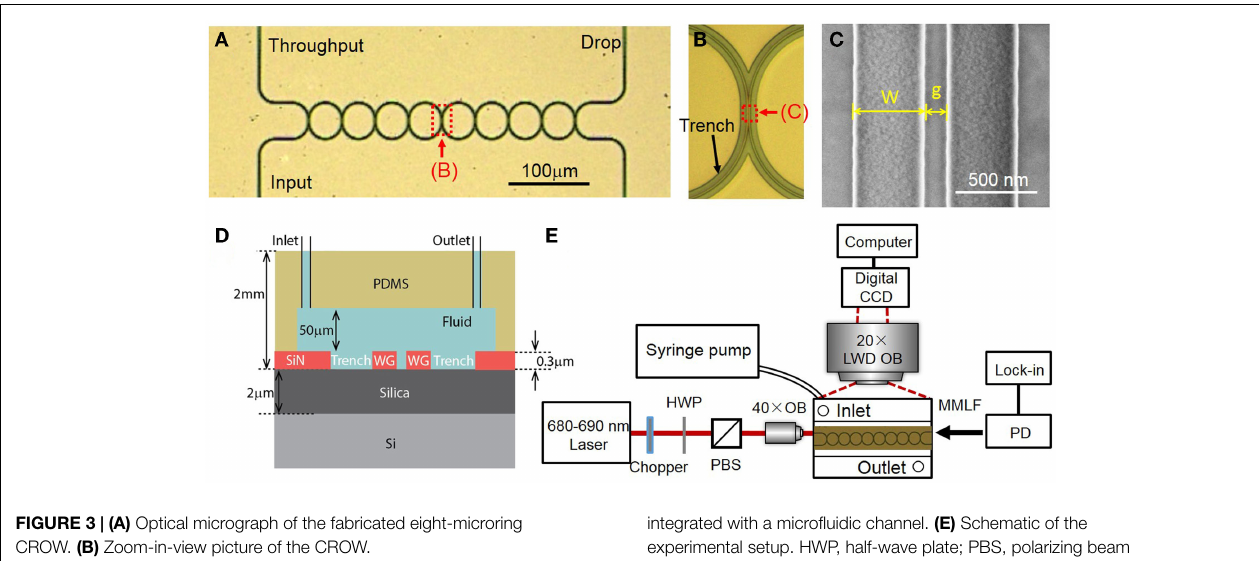
FIGURE 3 | (A) Optical micrograph of the fabricated eight-microring CROW. (B) Zoom-in-view picture of the CROW. (C) Scanning-electron microscope image of an inter-cavity coupling region of the CROW. (D) A cross-sectional view of the SiN chip